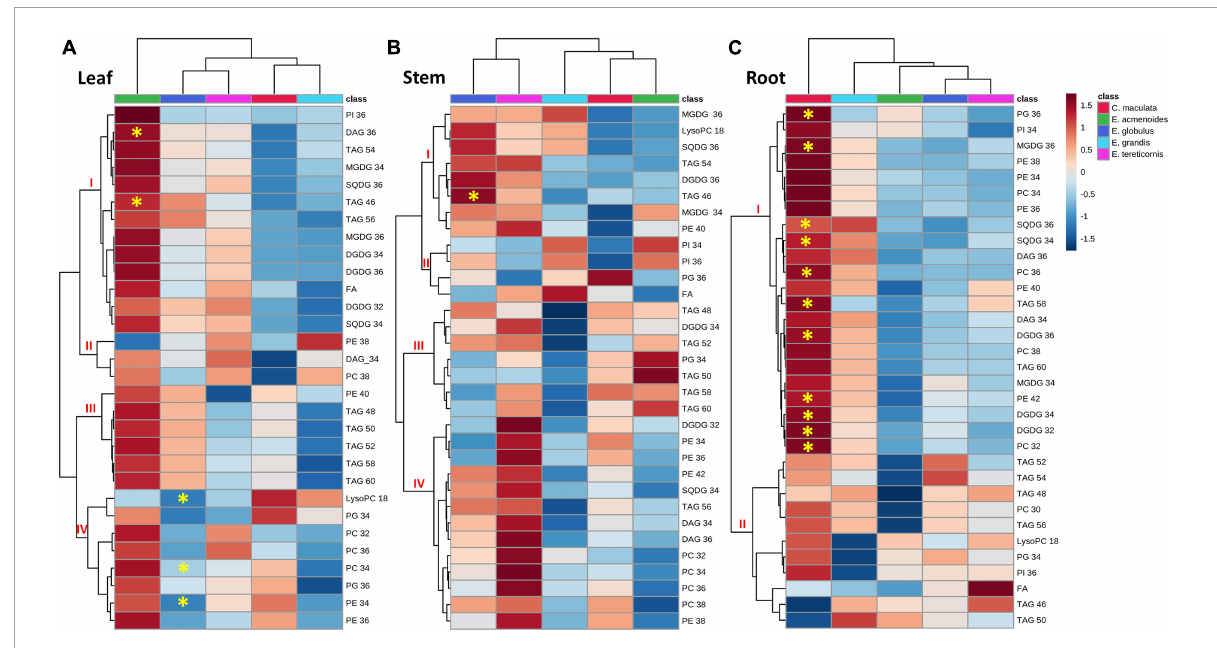
FIGURE5 Hierarchical cluster analysis of changes in lipid profiles from five eucalypt species cultivated in soil with low (Low P) and sufficient (Suf P) availability of phosphorus. Heat map representing the changes of log2 ratios (Low P/Suf P) lipid content in leaf (A) , stem (B) , and root (C) individually. Regions of blue or red indicate the metabolite level was decreased or increased, respectively. The clusters were generated in MetaboAnalyst using squared Euclidean distance and complete linkage. Asterisks indicate statistically significant differences ( P < 0.05) by Student’s t -test between treatments. MGDG, monogalactosyldiacylglycerol; DGDG, digalactosyldiacylglycerol; SQDG, sulfoquinovosyldiacylglycerol; FA, fatty acid; PI, phosphatidylinositol; PG, phosphatidylglycerol; PC, phosphatidylcholine; PE, phosphatidylethanolamine; LysoPC, lysophosphatidylcholine; LysoPA, lysophosphatidic acid; TAG, triacylglycerol; DAG,